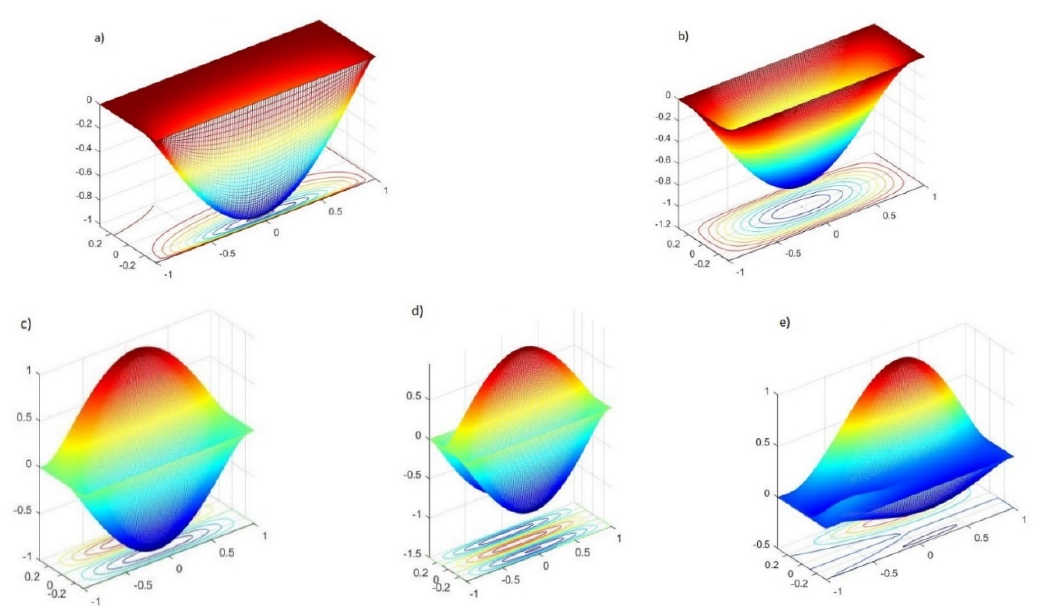
Figure 13. Vibrational modes for the UD distribution without the agglomeration effect: ( a ) 1st mode,